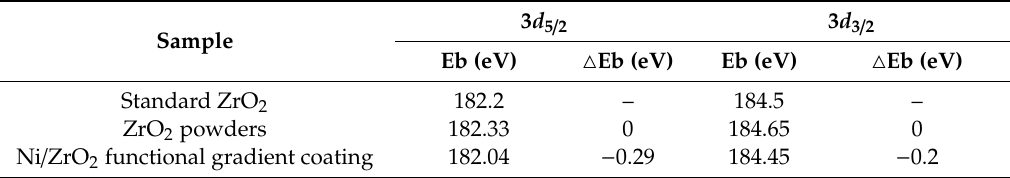
Table 8. 3 d electron binding energy of Zr in each